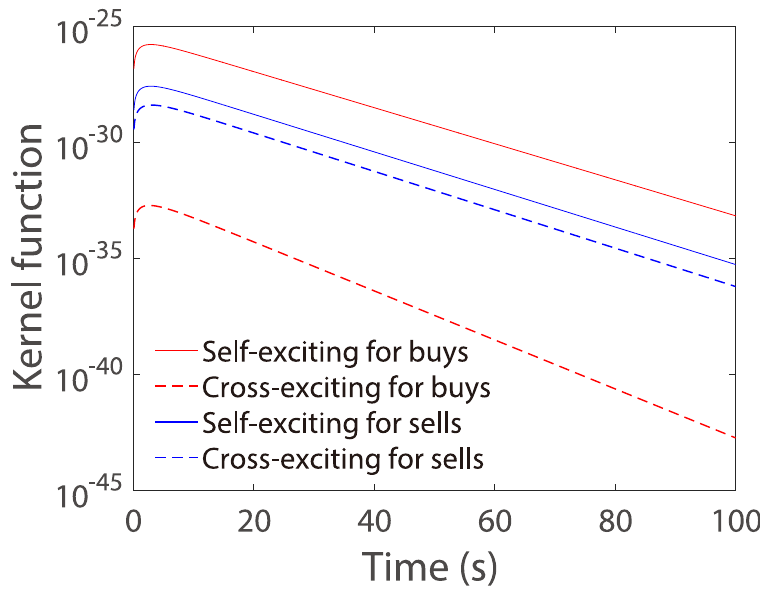
Fig 8. The estimated kernel functions ϕ ( u ) for aggressive market buy orders and for aggressive market sell ij orders. The coefficients used in the kernel functions are the average values of 42